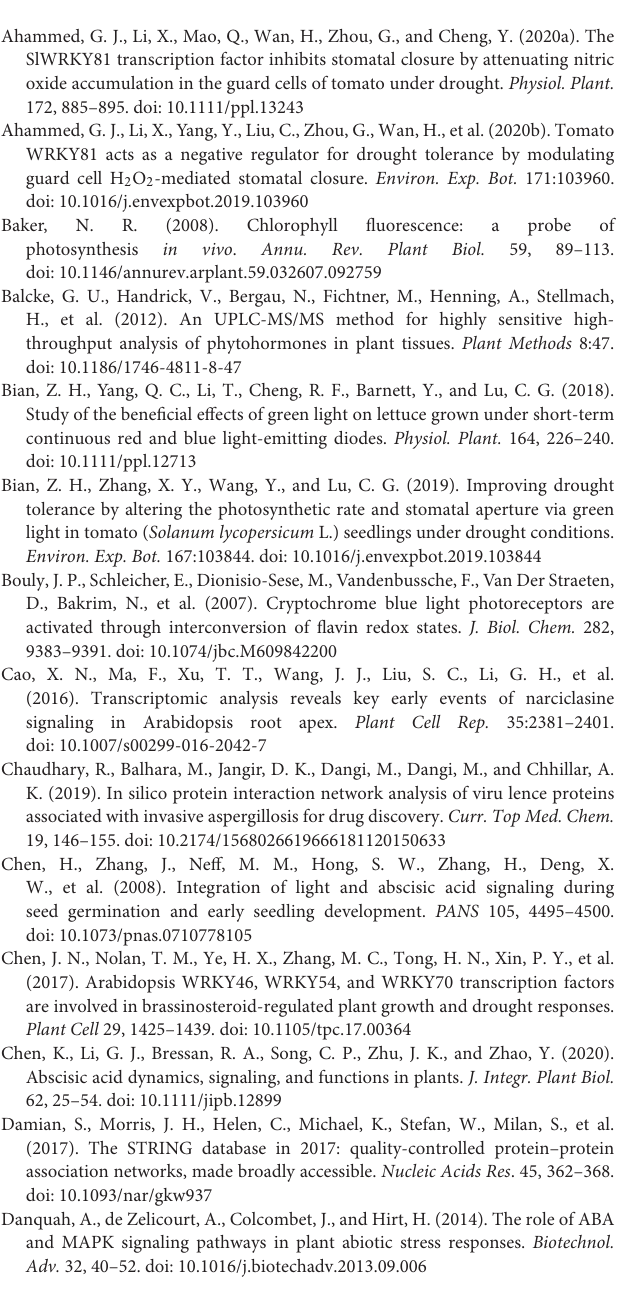
Supplementary Table 2 | GO enrichment analysis. Supplementary Table 3 | The transcription factor analysis of plants under drought stress by